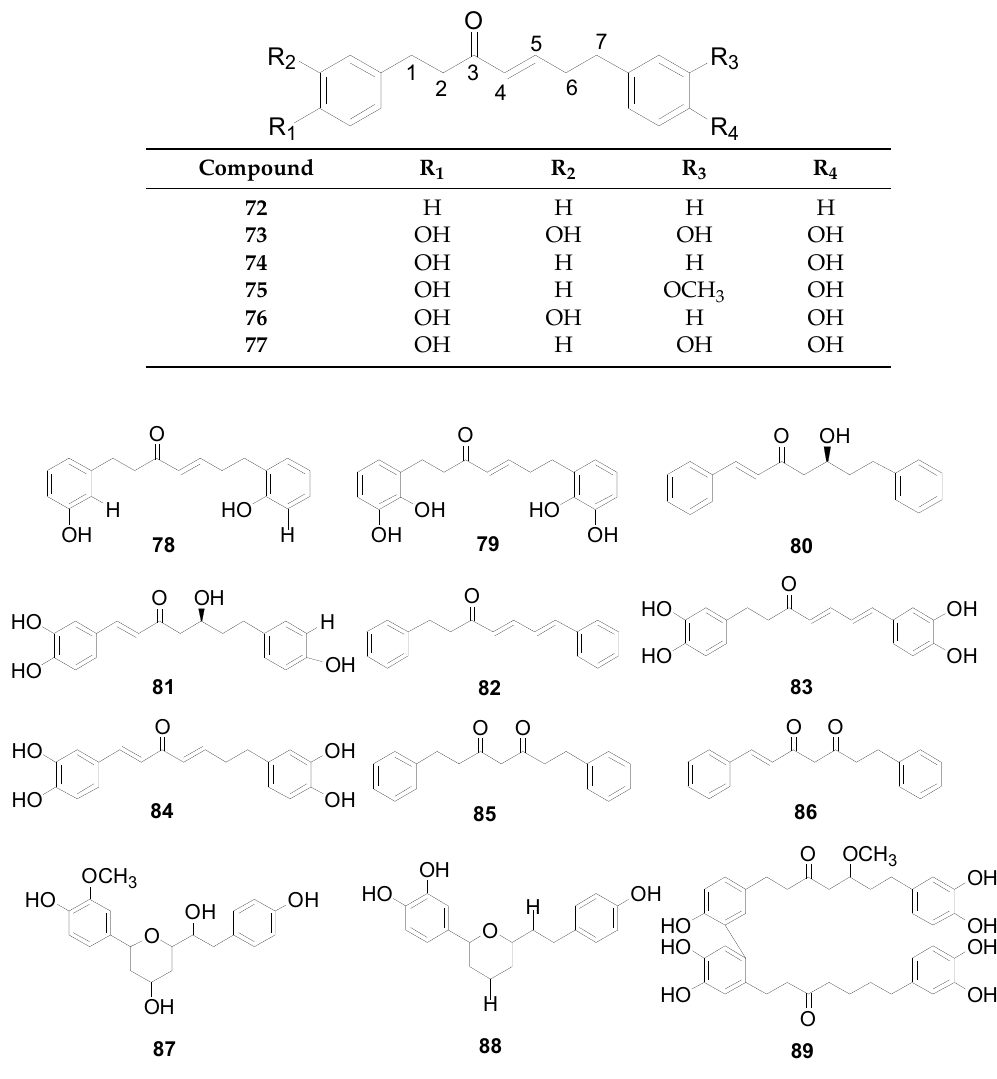
Table 3. Structures of compounds 72 – 77 .